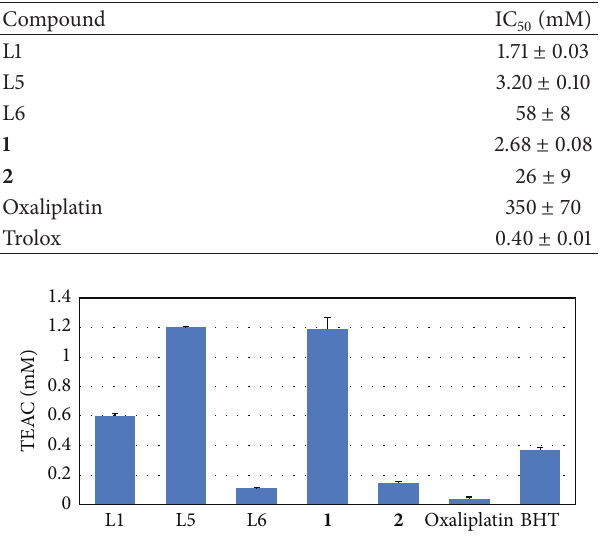
Figure 1: Antioxidant activity (Trolox equivalent activity capacity, TEAC) at 1mM concentration, in FRAP assay.